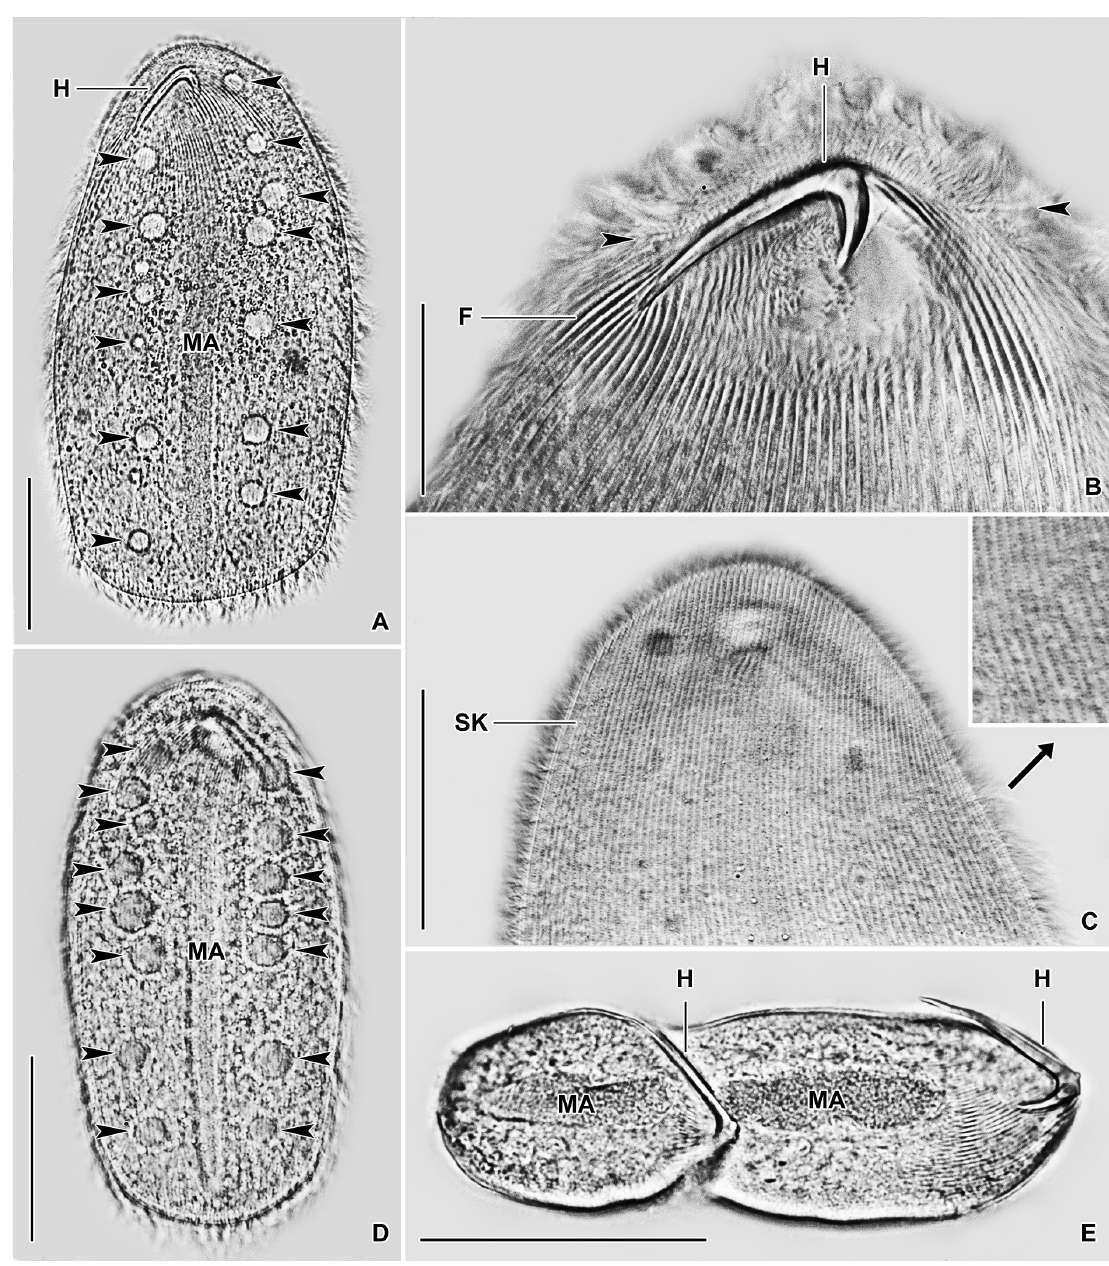
Fig. 7. Metaradiophrya varians (de Puytorac, 1954), Slovak specimens in vivo . A, D . Ventral view of representative specimens, showing the typical body shape, localization of the fibrillar hook, the long rod- like macronucleus and two staggered rows of contractile vacuoles (arrowheads). B . Detail of the anterior body portion, showing the fibrillar hook and its associated fibers. There are 5 or 6 fibers attached to the upper right side of the longer arm, on average 26 (22‒29) fibers to the ventral side of the longer arm and 11 or 12 fibers to the left side of the shorter arm. Arrowheads mark the subapical suture extending from the right body margin over the fibrillar hook towards the left body margin. C . Dorsal view, showing the somatic kineties. The ciliary rows are narrowly arranged and are composed of very densely spaced basal bodies (left inset). E . Ventral view, showing a late divider. Scale bars: A, C–E = 50 µm; B = 20